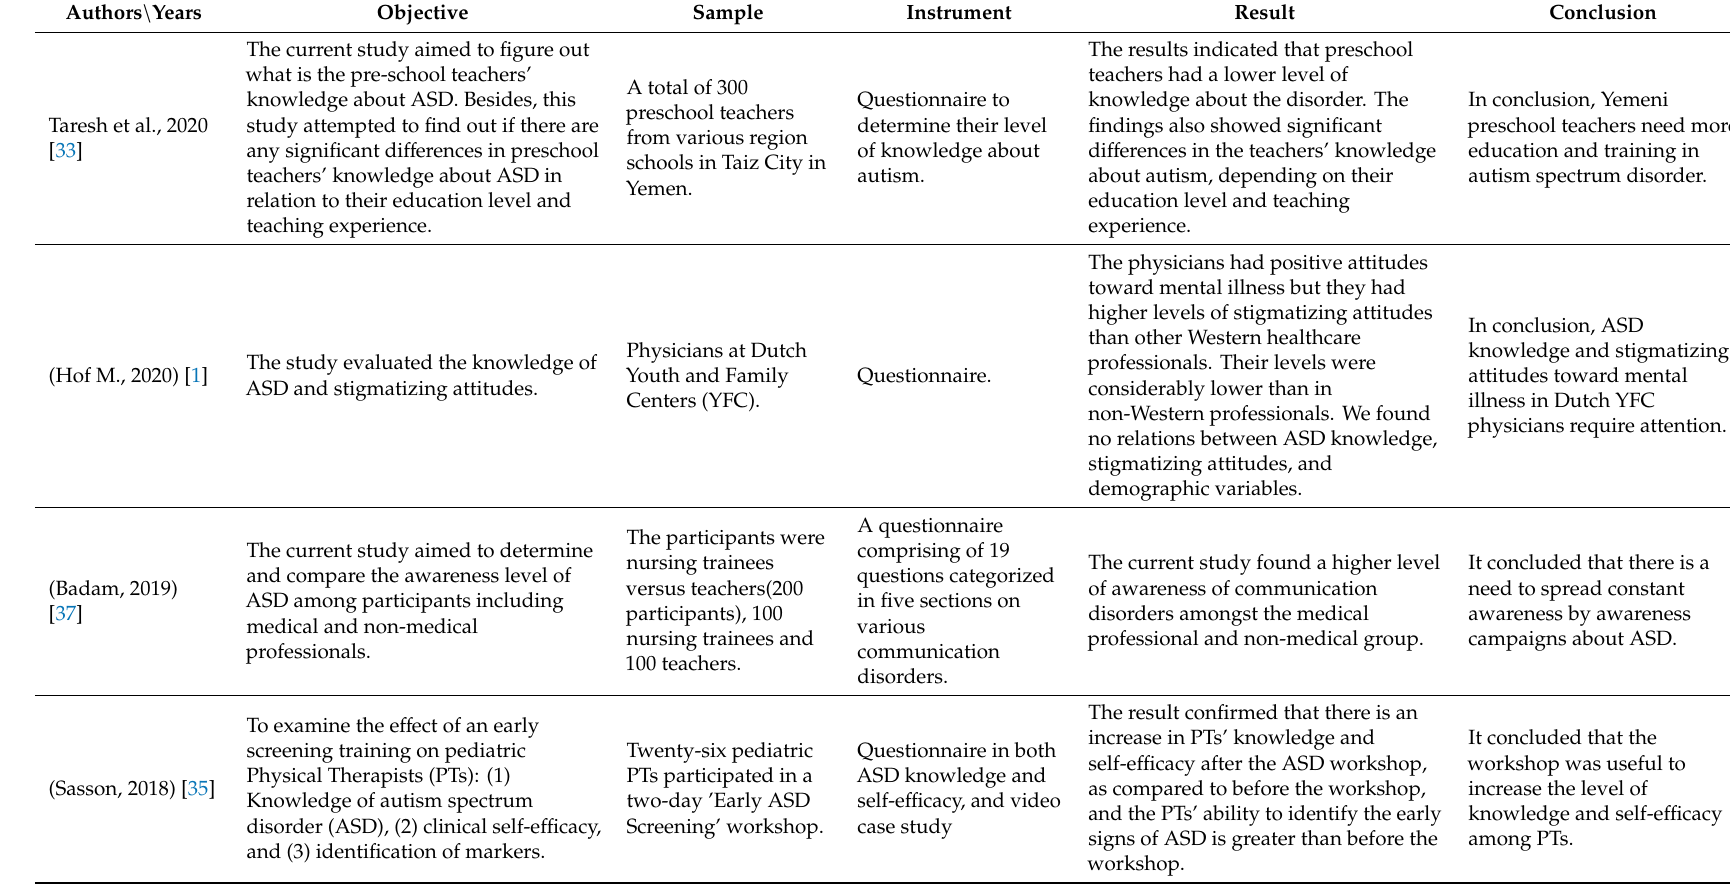
Table 1. Summary studies of knowledge about autism spectrum disorder